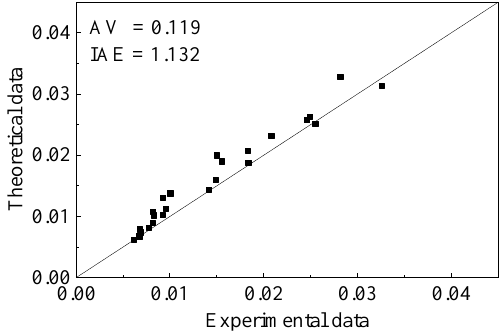
Figure 3. Performance of the peak strain model.